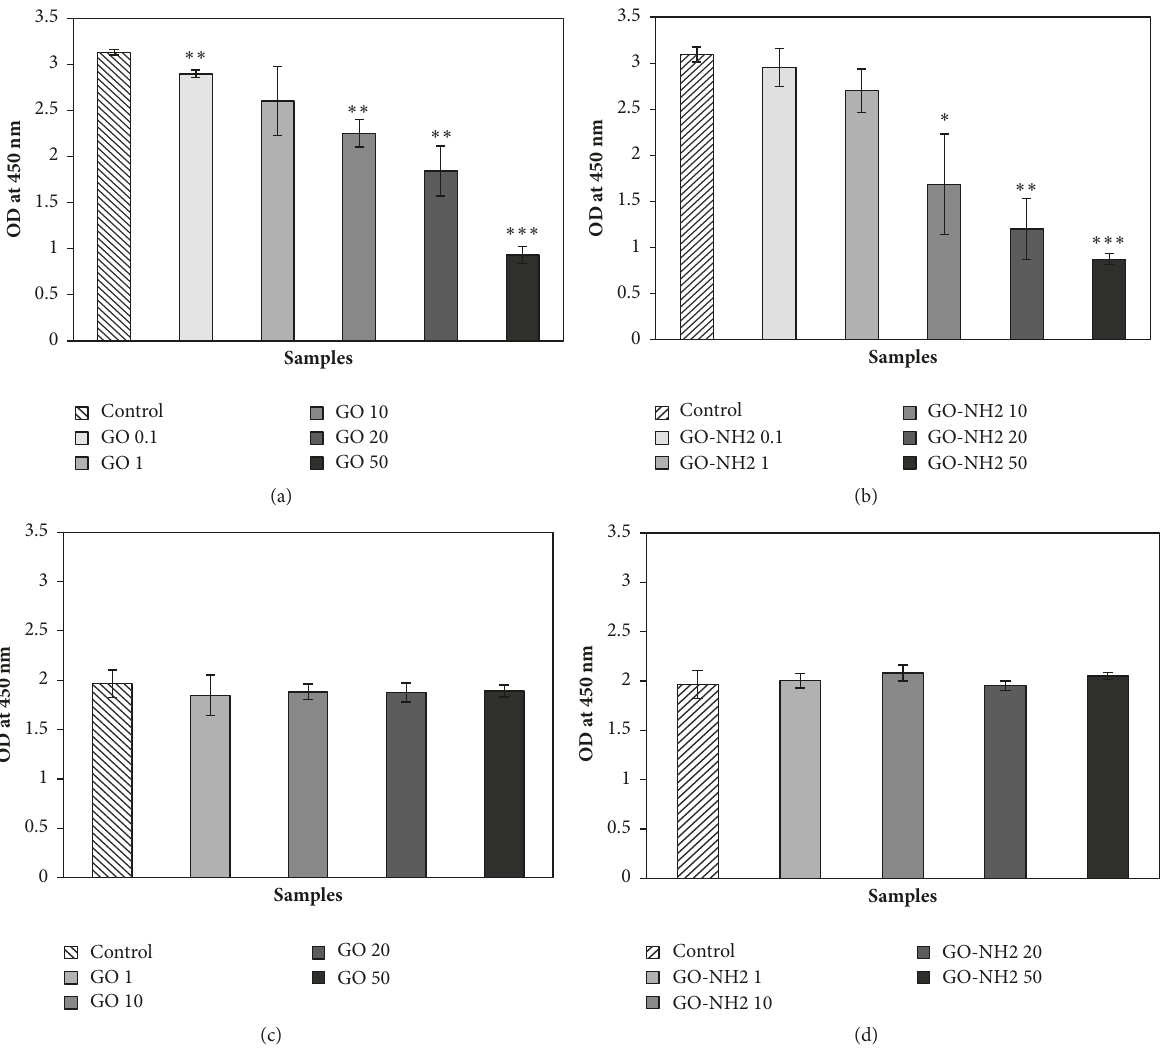
Figure 10: Proliferation activity of the two cell types after 48 hours incubationin the presence of the nanoparticles: A549 cells incubatedwith (a) GO and (b) GO-NH 2 ; Lep3 cells incubated with (c) GO and (d) GO-NH 2